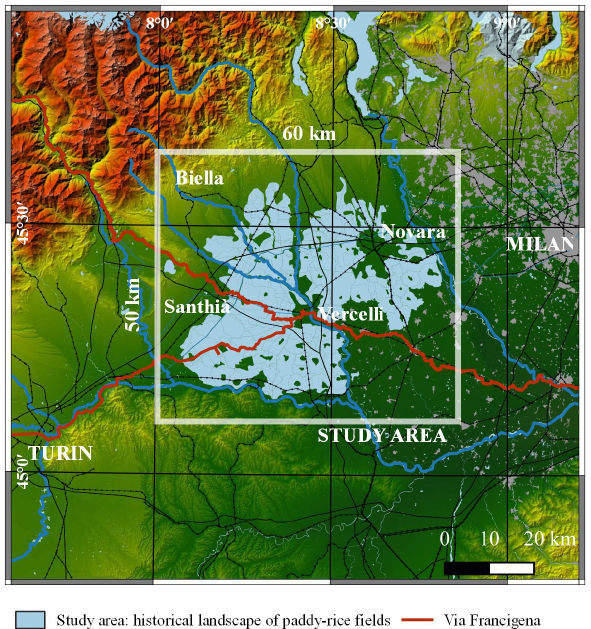
Figure 1 . Map of the study area. The research refers to a flat landscape, surrounded by the Alps, in-between Turin and Milan.